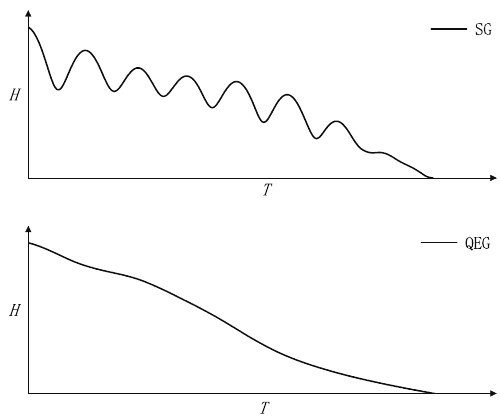
Figure 1. The schematic diagrams of SG and QEG